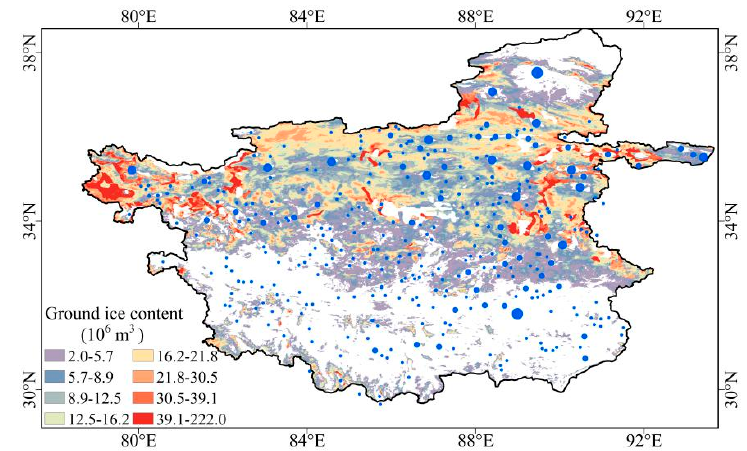
Figure 6. The spatial patterns of lake expansion and ground ice content over the endorheic basin. The black line contour is the QTP endorheic basin.